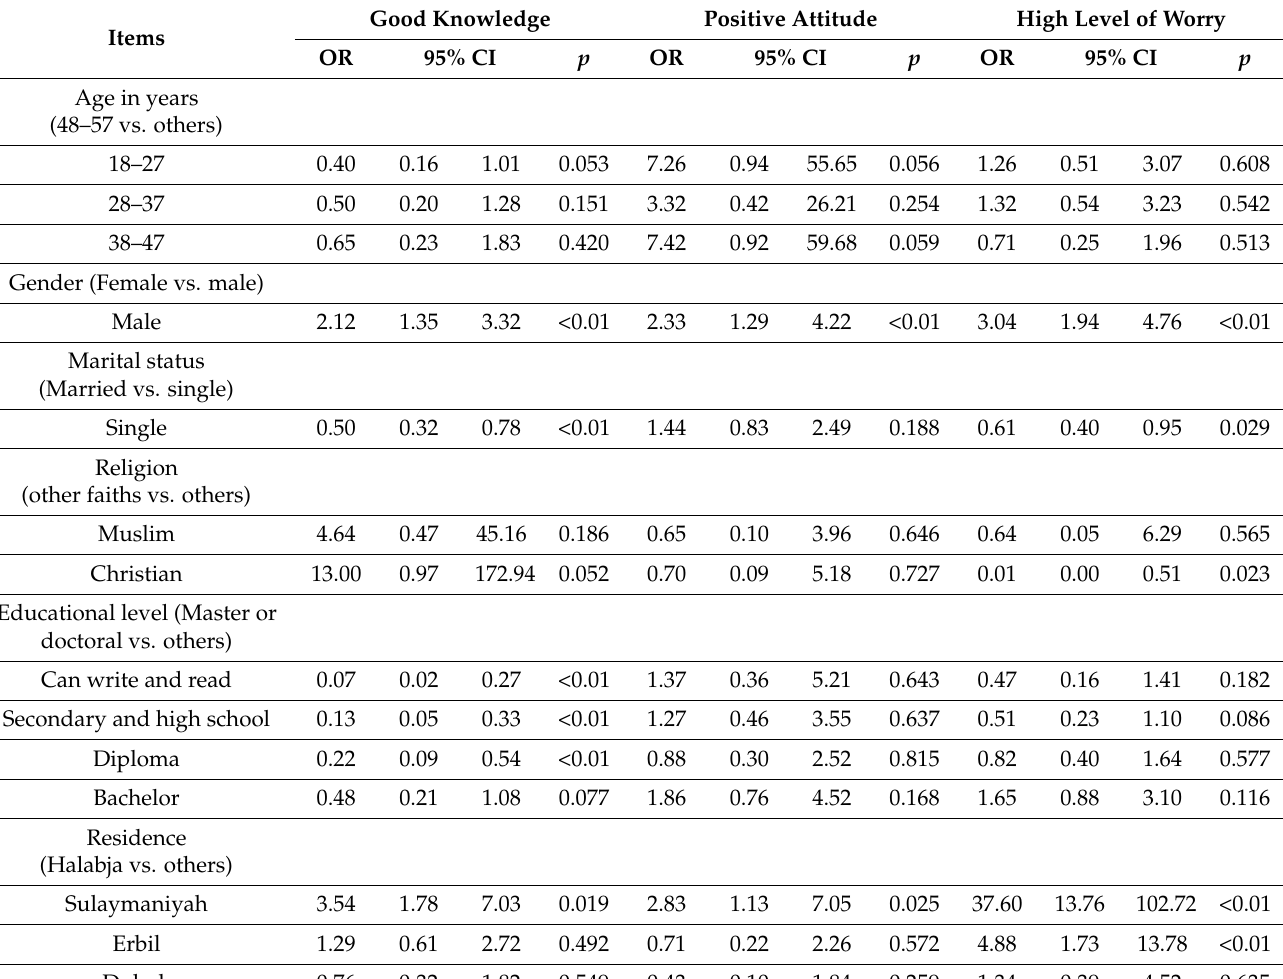
Table 4. Univariate logistic regression analysis to evaluate the predictive factors associated high knowledge, attitude and worry scores toward mpox ( n =